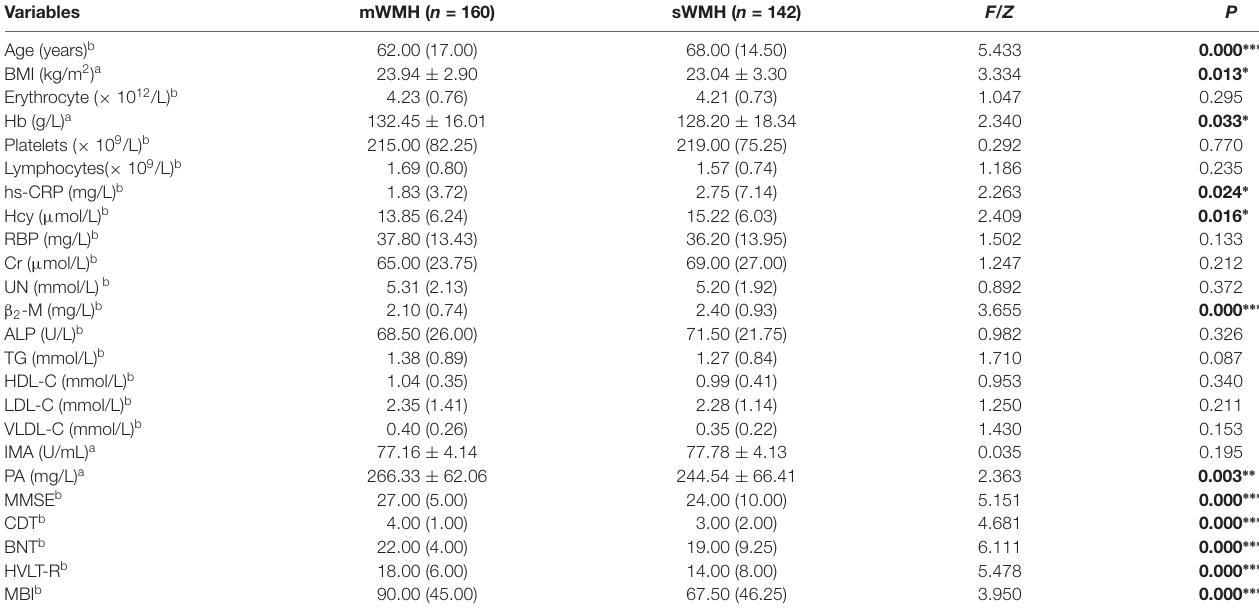
TABLE 2 | Comparison of variables between the mWMH and sWMH groups. Variables